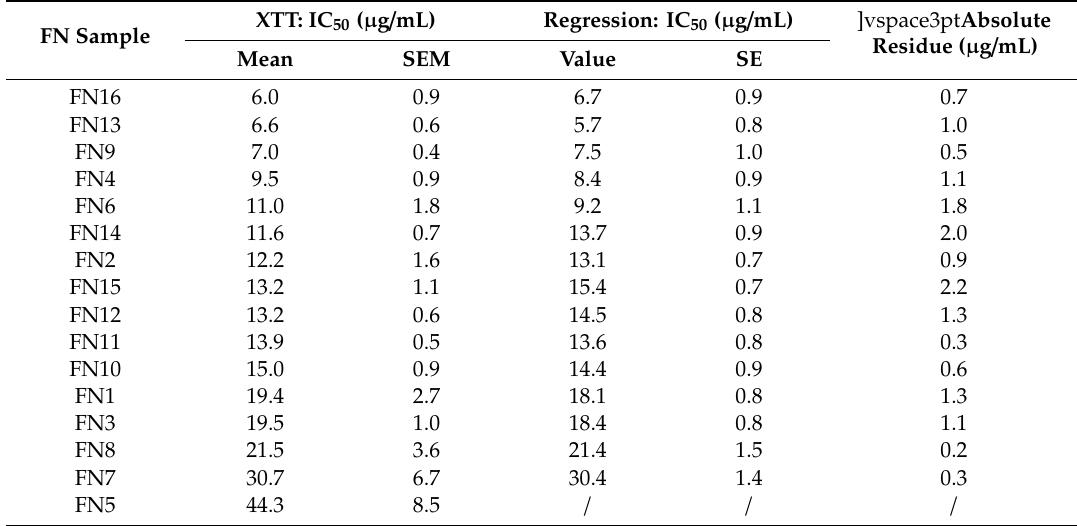
Table 3. Cytotoxic e ffi cacy of FNs against MDA-MB-231 cell line. XTT: IC 50 ( µ g / FN Sample